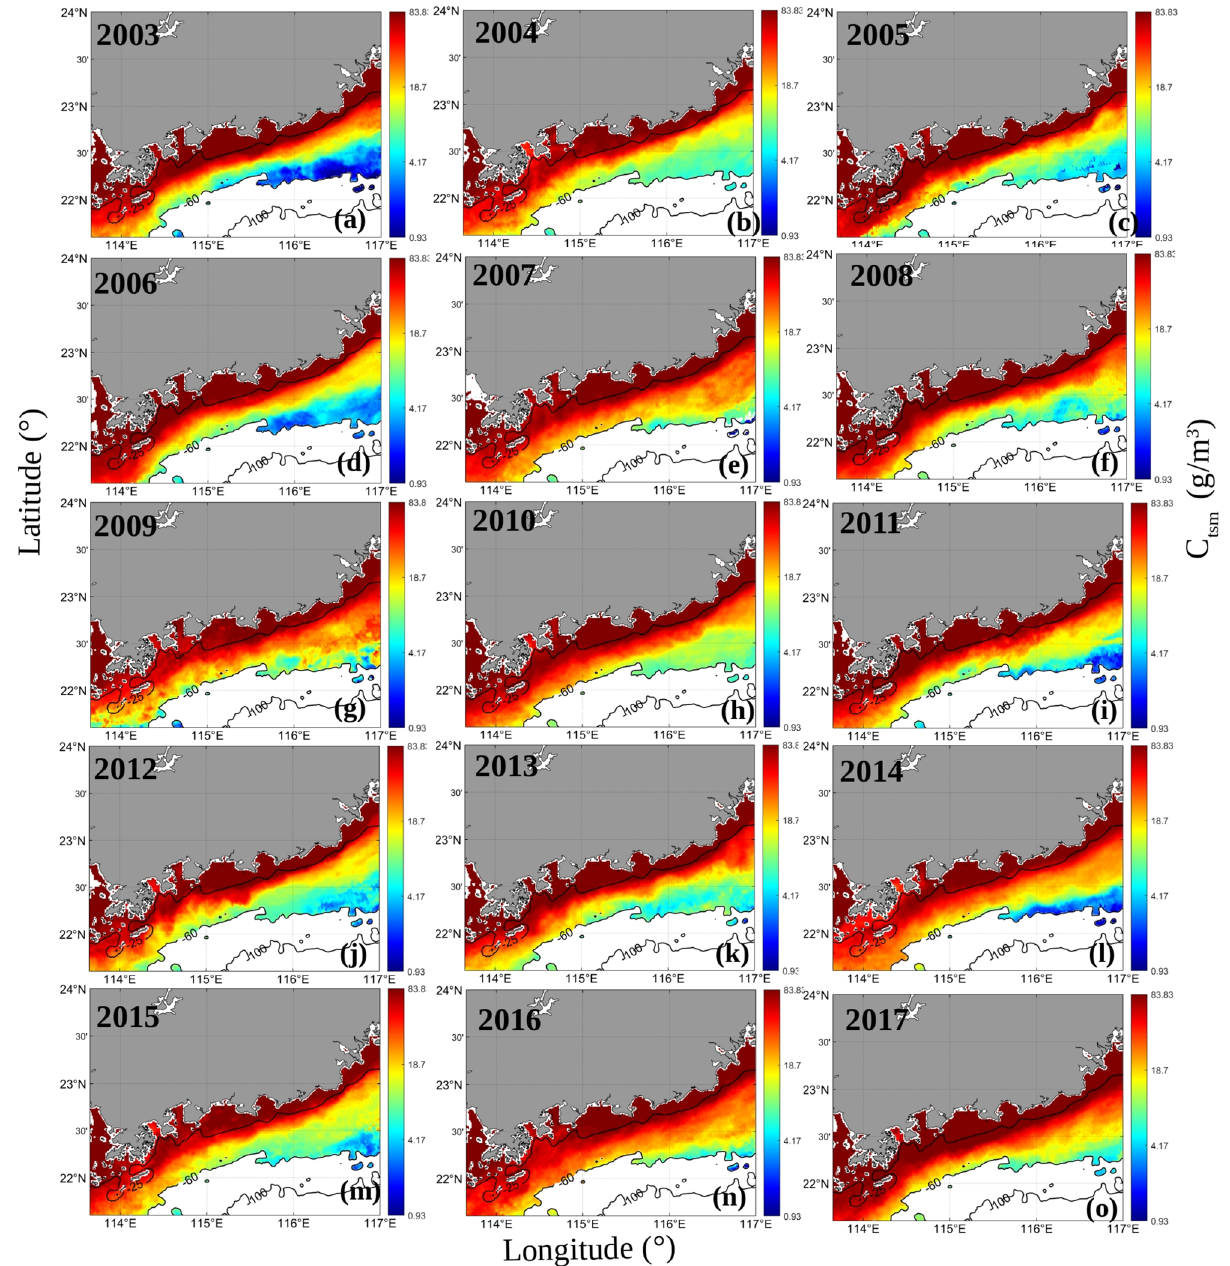
Figure 5. The mean C tsm (g m −3 ) values between November and December from 2003 to 2017. The program R (version 3.6.3, available at https:// www.r- proje ct. org) was applied for the vailed from November 2005 to February 2006. The downwelling that occurred due to Ekman transport was most pronounced in December. The overlap between the front observed in the K d (490) series and the downwelling region is most pronounced. C tsm is most closely associated with K d (490). Based on the temporal-spatial distribu- tions of K d (490) and C tsm from September 2005 to February 2006, fronts were not formed by September 2005. A front started to appear but was still hardly detectable in October. With the influence of downwelling-favorable winds and Guangdong coastal currents, the fronts became stronger and were most pronounced in December 2005. The fronts extended from the southeastern coast of Guangdong Province to the Wanshan Archipelago in the SCS. Then, the fronts became weaker and gradually disappeared after January 2006. The spatial distribution of K d (490) appeared to indicate a decrease in the offshore direction due to the nearshore sediment suspension. However, in January and February 2006, there appeared to be a location where the sediments rose to the surface offshore. This could be attributed to the intense southwestward currents that brought sediments from the north- ern area to this region. The monthly average global surface current velocities from the HYCOM data were cal- culated and are given in Fig. 12. The results showed that waters with high nutrient and sediment contents in the ZFC in the southern part of the ECS could flow into the SCS. However, the influence of the ECS coastal waters